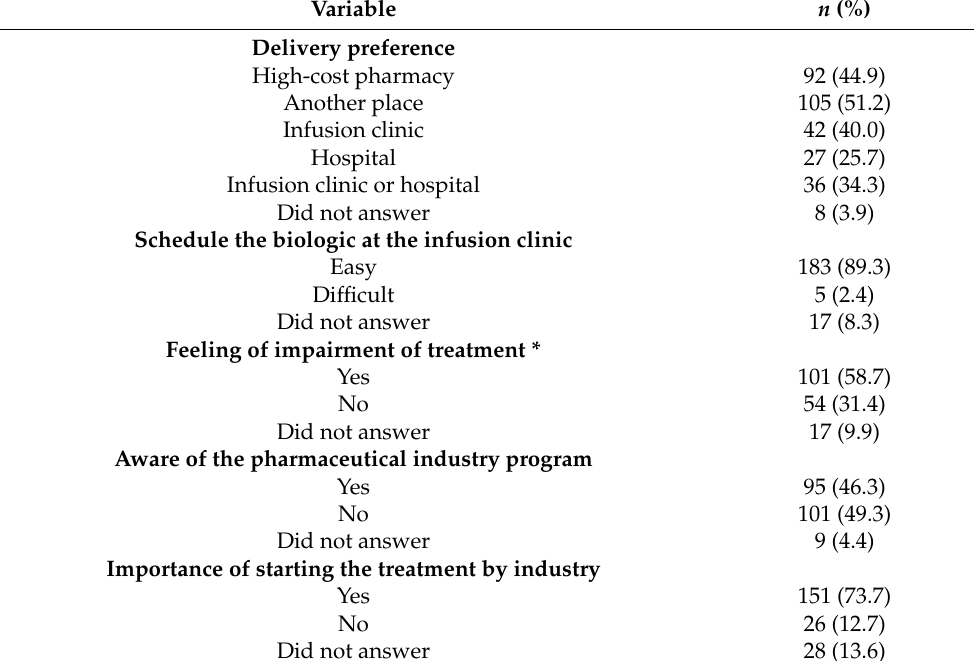
Table 3. Patient perception of biologic